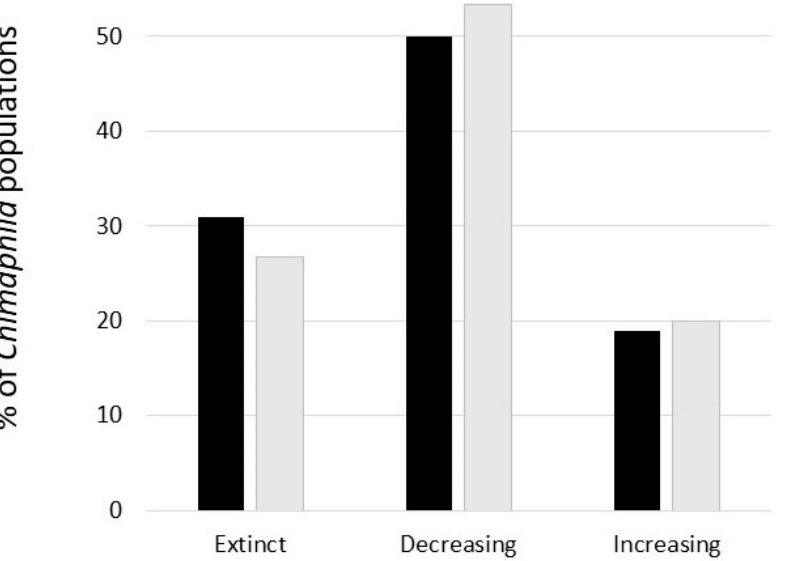
Figure 5. The fate of Chimaphila umbellata populations based on two sources. Black bars: based on surveys of more than 600 populations from the 1990s onwards and re-surveys on average 10 years later [101]. Grey bars: this study, based on a re-survey in 2021 of 30 populations recorded in 2013 [114].